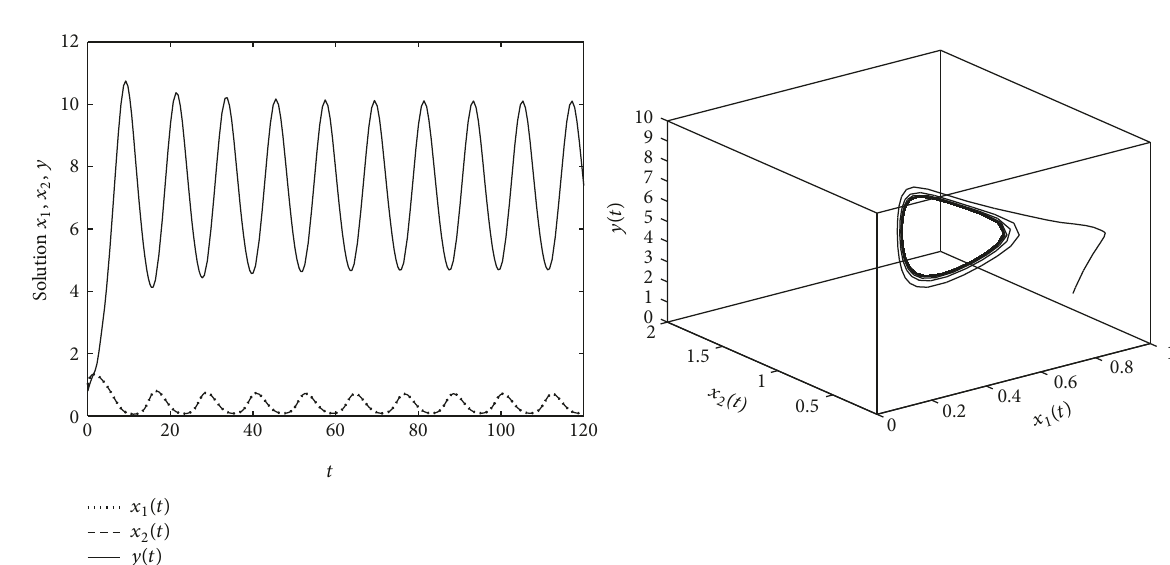
Figure 3: The behavior of 𝑥 1 , 𝑥 2 , and 𝑦 with respect to 𝑡 for Example 6 with 𝜏 = 1.8 .